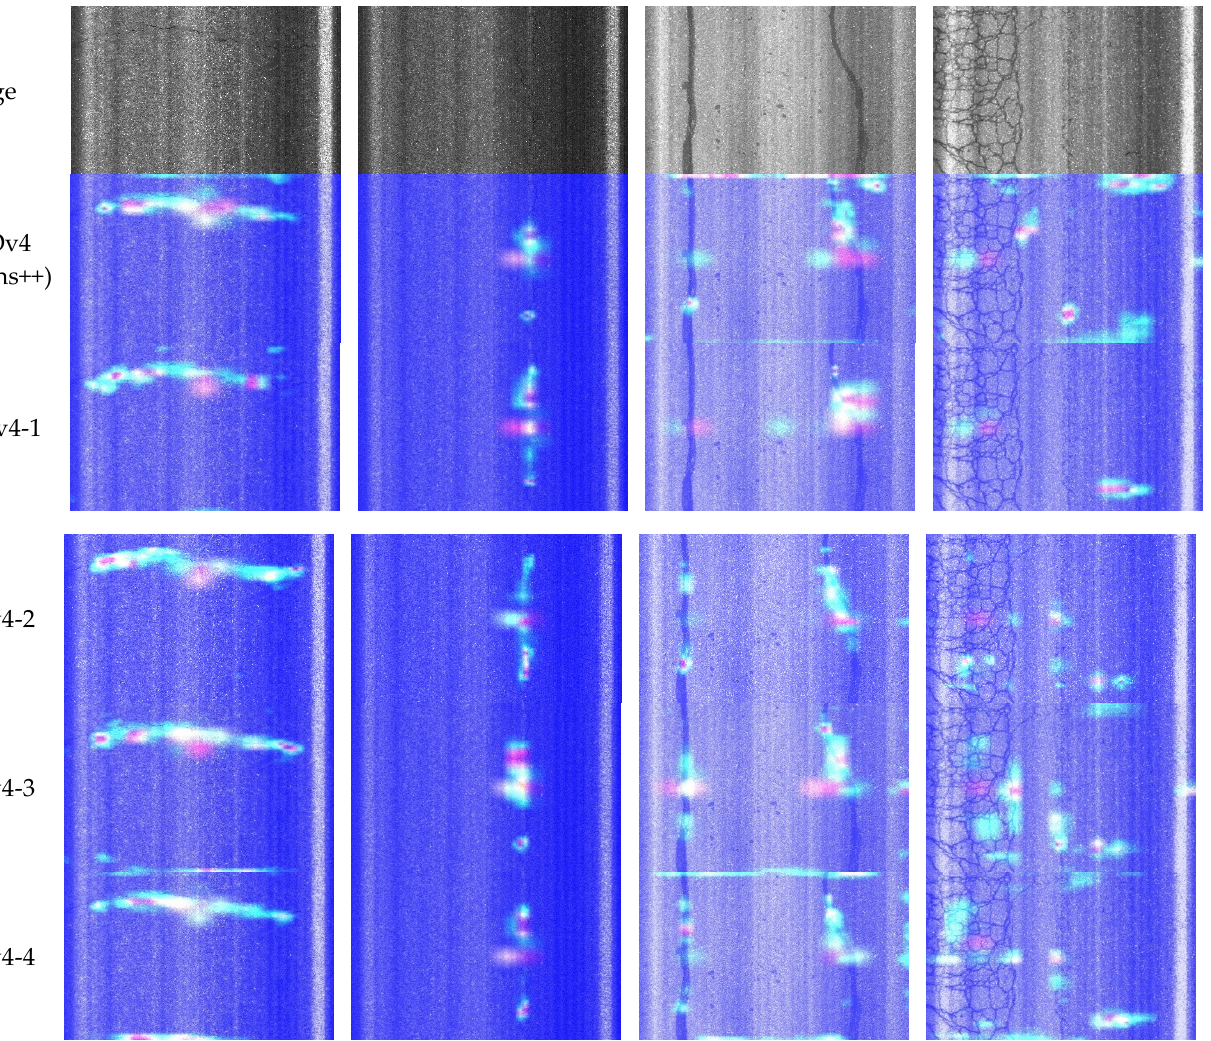
Figure 12. Visualization of the three output feature layers after superimposition.